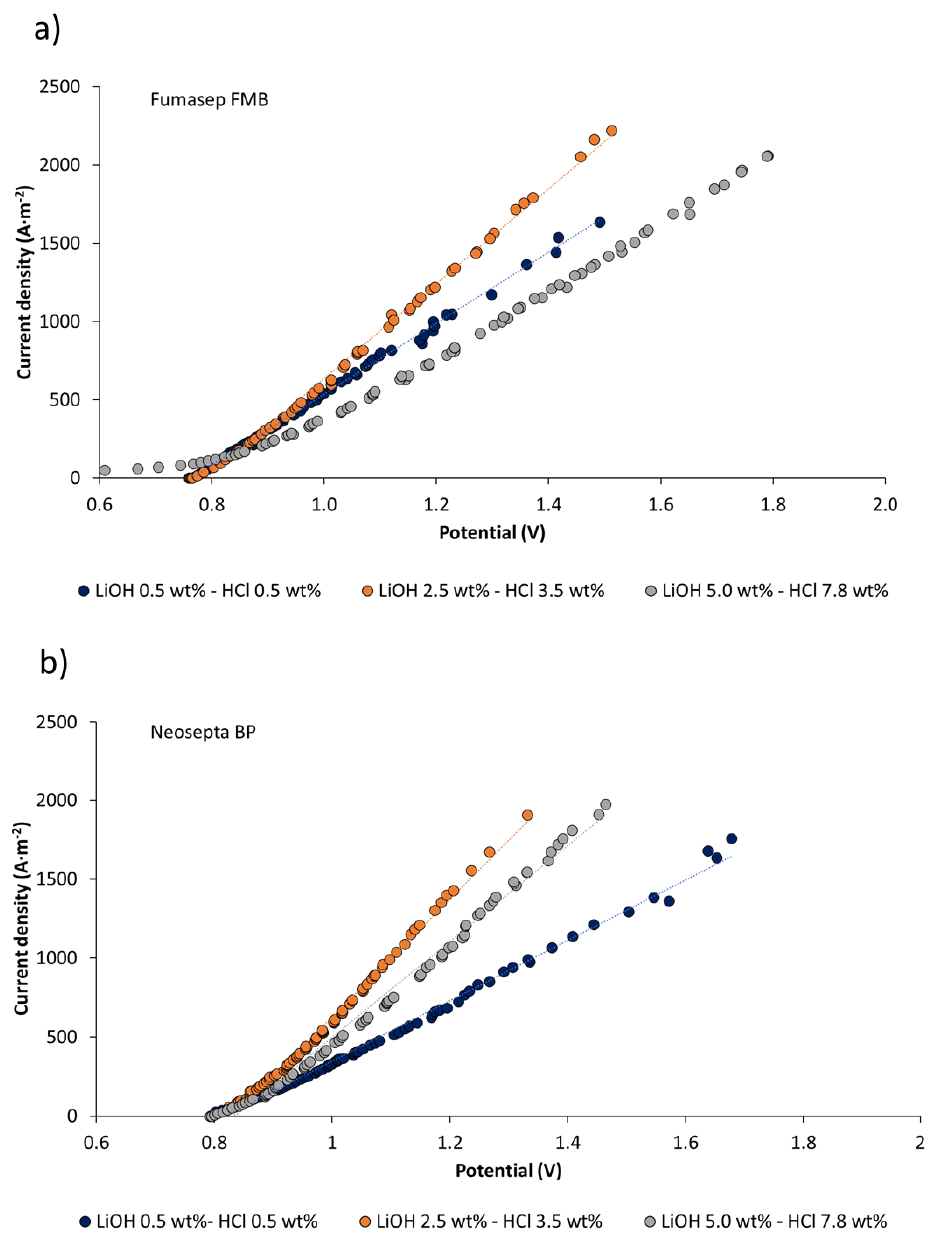
Figure 8. Linear sweep voltammetry of bipolar membranes under production operating conditions: ( a ) Fumasep FBM; ( b ) Neosepta BP.